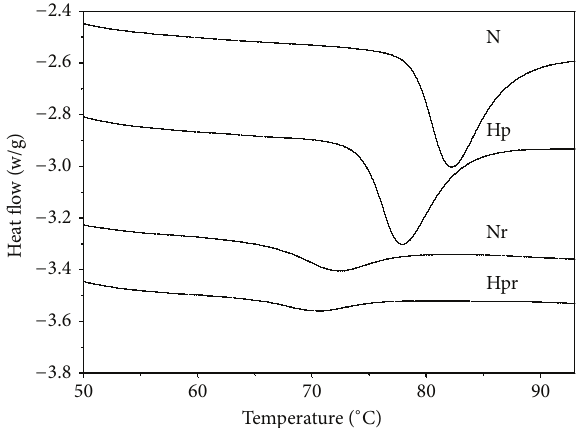
Figure 1: Representative DSC curves of the native and hydrox- ypropylated starch. Gelatinization of the native starch (N), hydrox- ypropylated starch (Hp), retrogradation of native starch (Nr), and retrogradation of hydroxypropylated (Hpr) sweet potato starch